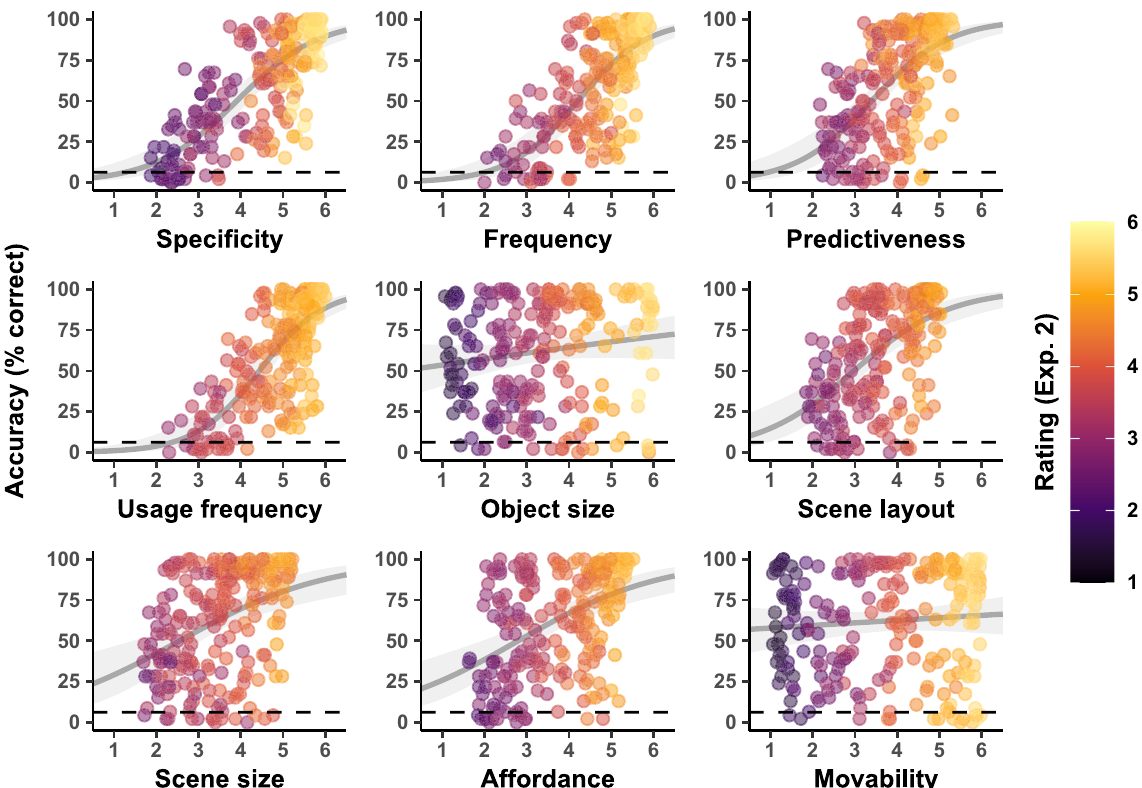
Figure 4. Observed basic-level scene categorization accuracy in Experiment 3 as a function of different ratings of object properties. Points represent the respective rating and accuracy averaged across participants for each individual image in Experiment 3. The points’ colours indicate the mean ratings of the same images and items in Experiment 2. Smoothed lines are fixed-effect binomial approximations for illustrative purposes only. The dashed lines indicate the expected chance level in the basic-level scene categorization task